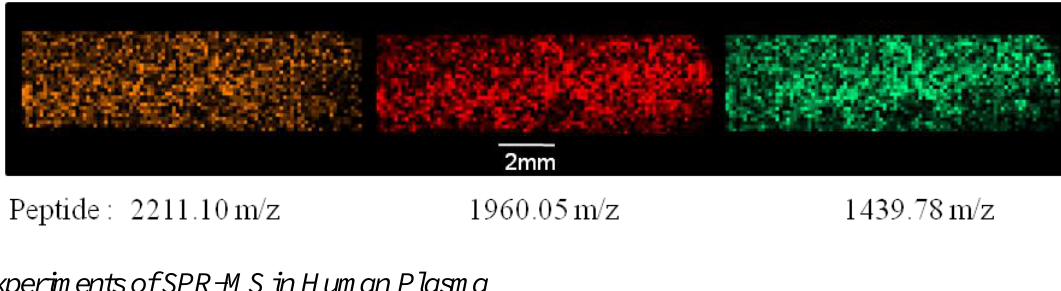
Figure 5. Peptide distribution 2211.10 (specific to trypsin), 1960.05 and 1439.78 (specific to RSA), after analysis of a 10 fmol/mm² RSA layer digested by trypsin at 30ng/µl with